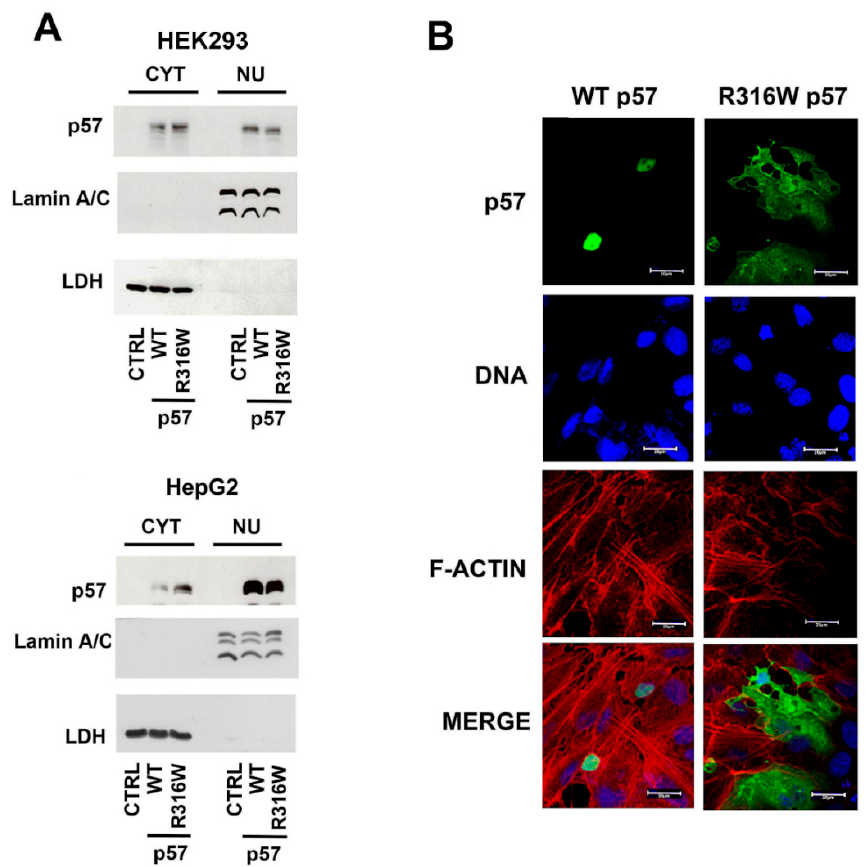
Figure 2. Subcellular localization of human WT- and R316W-p57. ( A ) WB analysis of the cytosolic and nuclear content of human p57 in HEK293 and HepG2 cell lines after 24 h of transfection with the empty vector (CTRL) and the plasmids encoding WT- and R316W-p57. Lamin A/C and LDH were analyzed to confirm the proper separation of nuclear and cytosolic fractions and as control for equal protein loading. ( B ) The subcellular localization of the WT and the mutated protein was investigated using immunofluorescence. HepG2 cells were stained with Alexa Fluor 488 (anti-p57 Ab, green), Hoechst 33342 (DNA, blue), and phalloidin (F-ACTIN, red). Representative images of cells overexpressing WT- and R316W-p57 were acquired using confocal microscopy with a 63x objective and are shown in panel ( B ). Scale bar 20µm. For further details refer to the Materials and Methods Section.